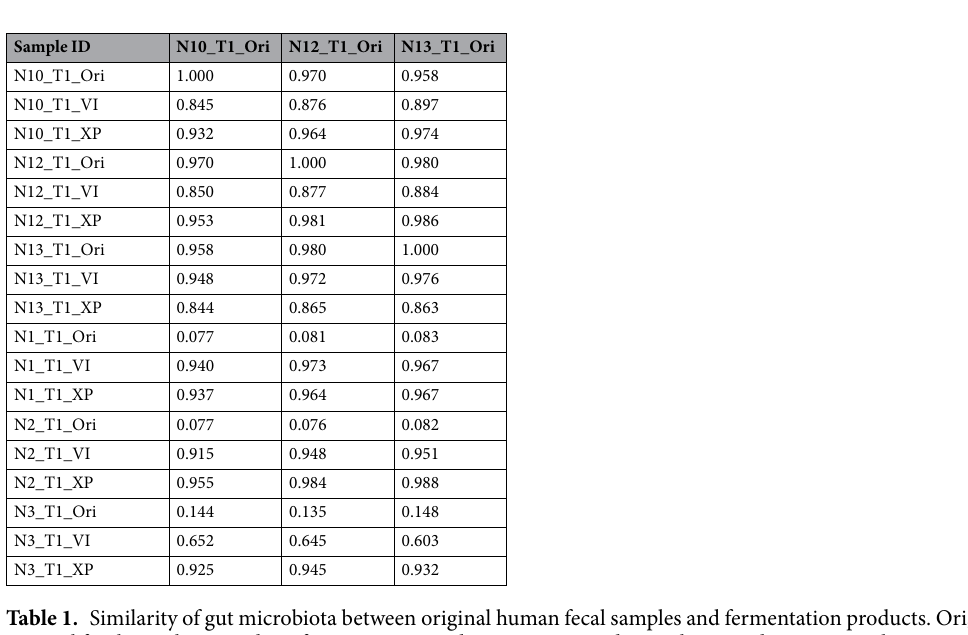
Table 1. Similarity of gut microbiota between original human fecal samples and fermentation products. Ori, original fecal sample; VI and XP, fermentation products using VI and XP culture media,